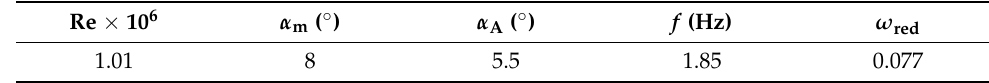
Table 1. Correlation pitching parameters of the validation.